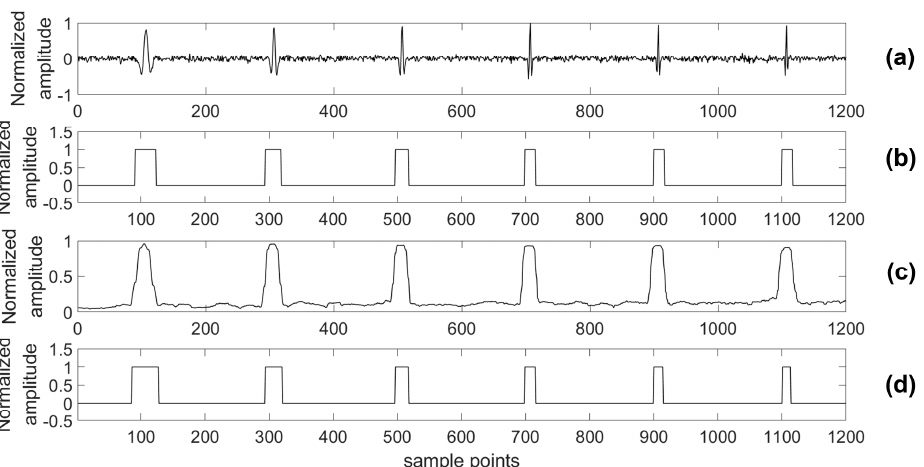
Figure 12. Channel A of test data (0 dB) and its results. ( a ) Test data (0 dB); ( b ) Detection results of the proposed algorithm; ( c ) Detection results of the short-term average to long-term average (STA/LTA) algorithm; ( d ) The real label.